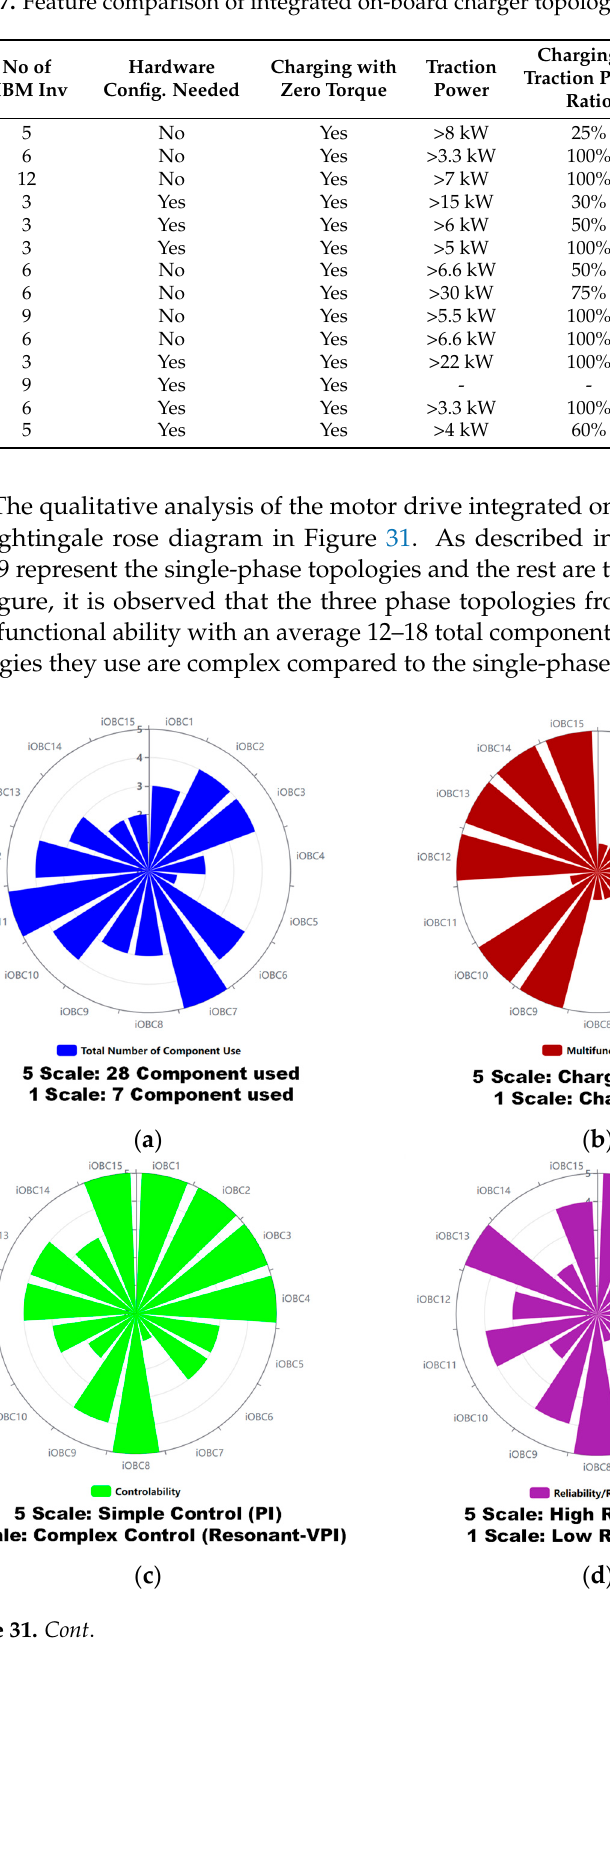
Table 7. Feature comparison of integrated on-board charger topologies.